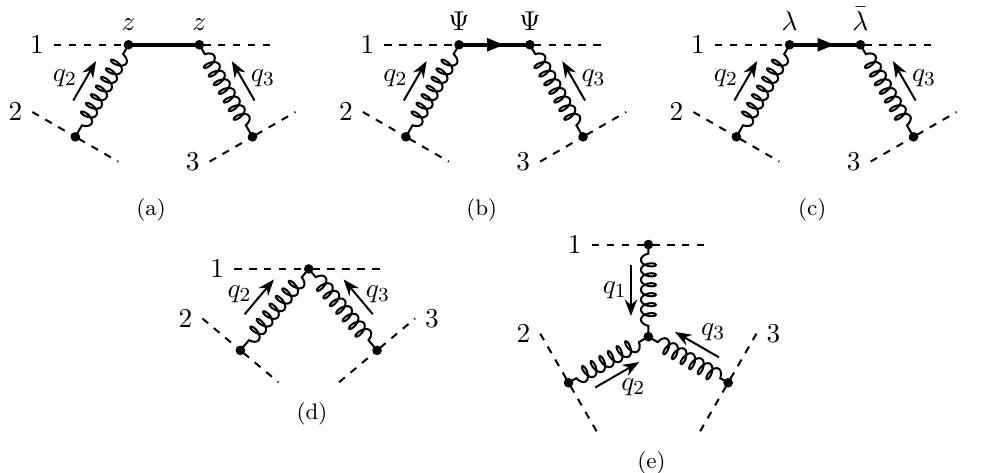
Figure 1 . The diagrams for the NLO eikonal with three worldlines. For diagrams involving the propagators of Ψ 1b and λ 1c, we also need to include the crossed diagrams that can be obtained by simply reversing the arrows on the worldline. We only display diagrams with worldline propagator and contact interaction of particle